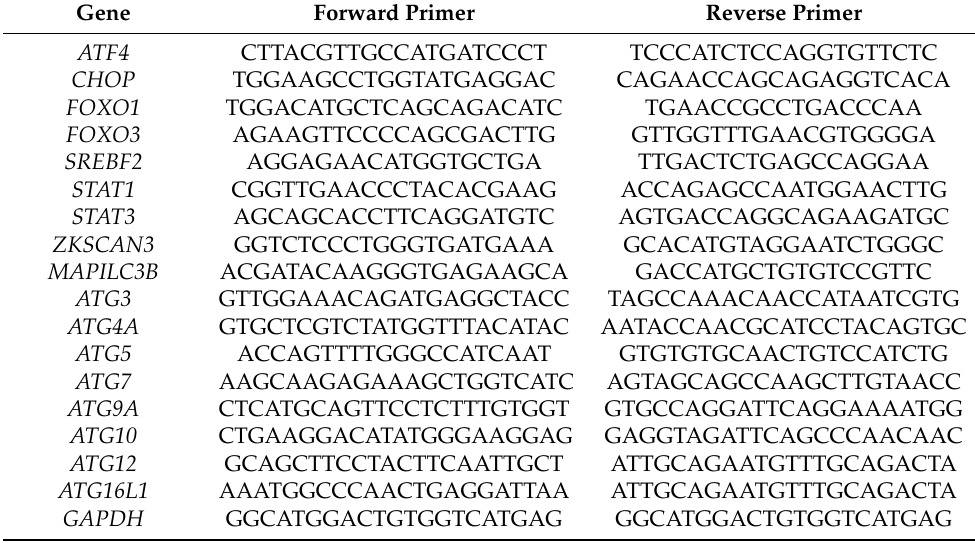
Table 1. The primer sequences used for real-time quantitative PCR or promoter cloning. Gene Forward Primer Reverse Primer ATF4 CTTACGTTGCCATGATCCCT TCCCATCTCCAGGTGTTCTC CHOP